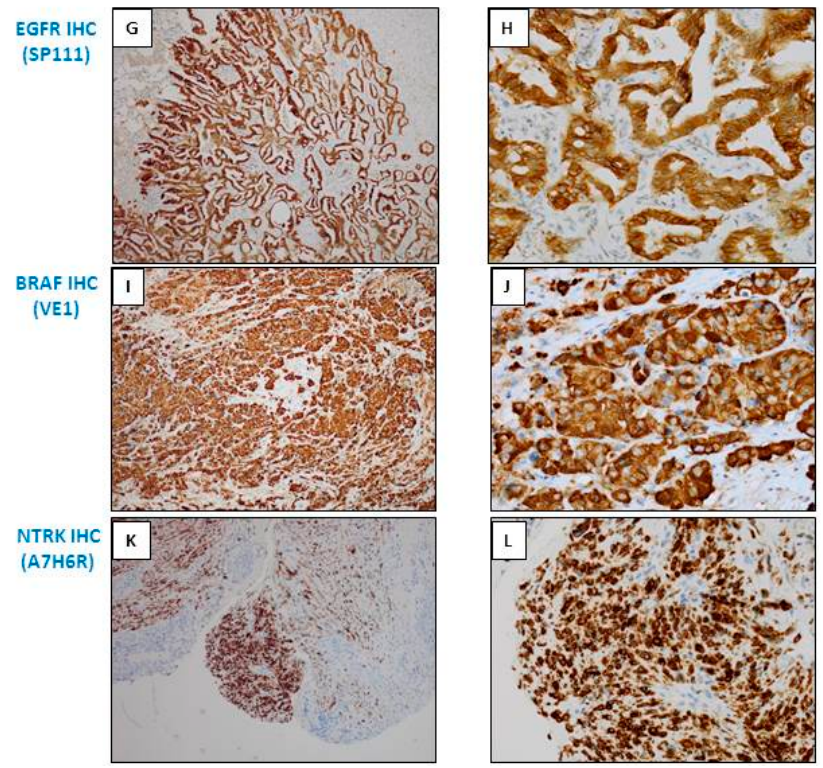
Figure 2. Examples of different types of staining of immunohistochemistry (IHC) obtained with bronchial biopsies with antibodies used as theranostic tools for lung adenocarcinoma. ( A , B ) ALK IHC (D5F3, Ventana); ( C , D ) ROS1 IHC (D4D6, Cell Signaling); ( E , F ) EGFR IHC (L858 EGFR mutation;